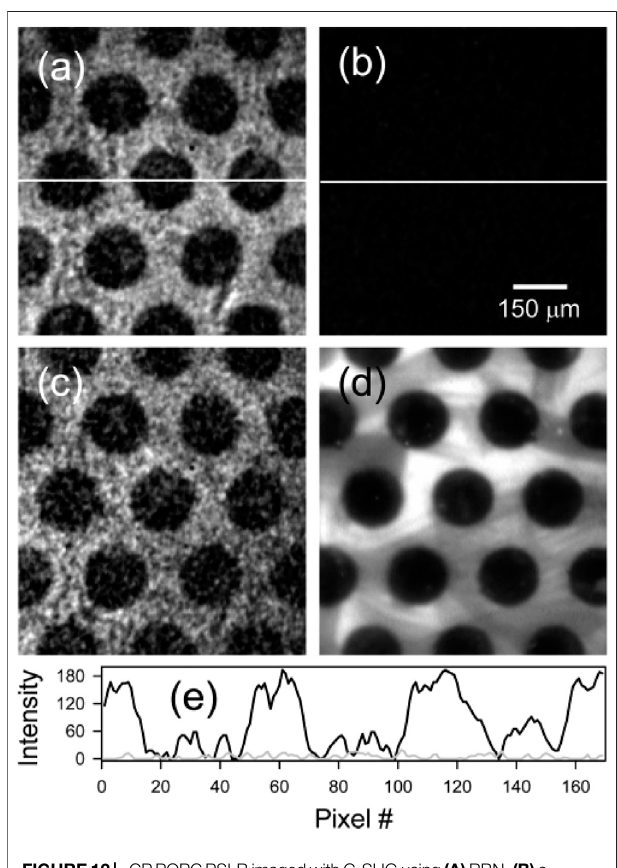
FIGURE12| μ CPPOPCPSLBimagedwithC-SHGusing (A) RBN, (B) a racemic mixture of RBN and SBN, and (C) SBN. A different bilayer was also imaged with Rh-DOPE using fl uorescence microscopy (D) . Line scans through the center of image a (black) and b (gray) are shown in part (E) . The fi gure and caption have been adapted with permission from Kriech and Conboy, (2005a), Copyright © 2005 American Chemical